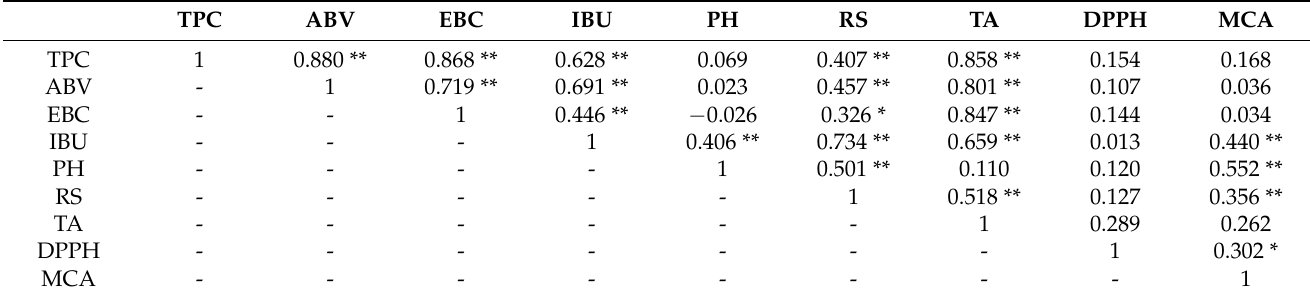
Table 3. Correlations among beer parameters, antioxidant activity evaluation indices and total phenolic